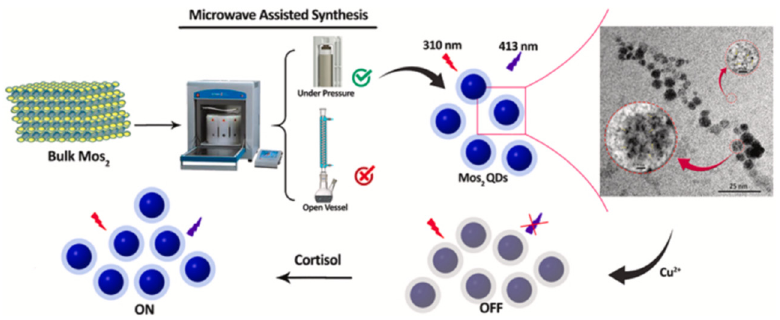
Figure 5. Overview of the microwave preparation of the on–off sensor for cortisol (adapted with permission from [55]. Copyright 2022 Elsevier).